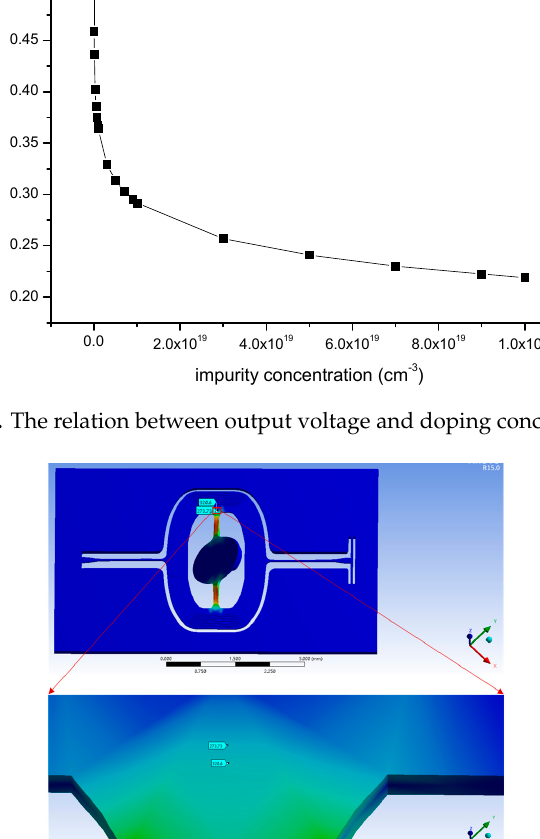
Figure 5. The shear stress at different positions on the torsional beam.